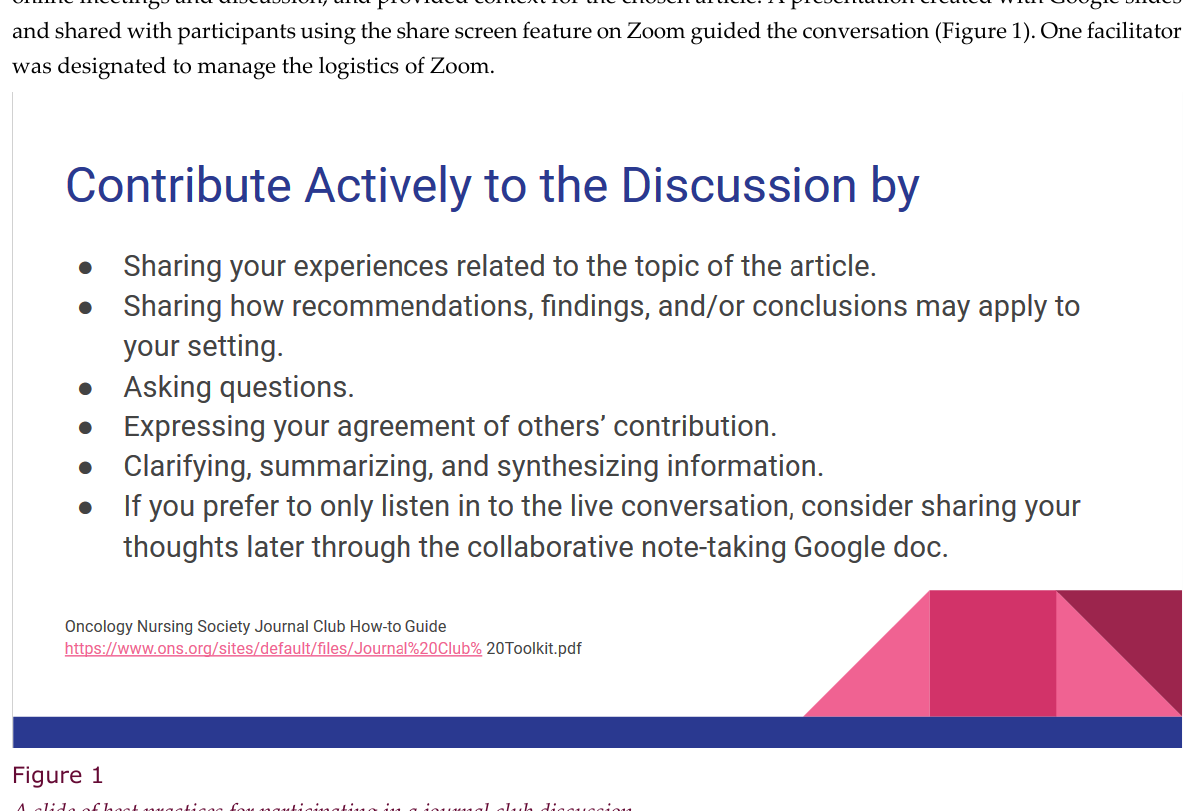
A slide of best practices for participating in a journal club